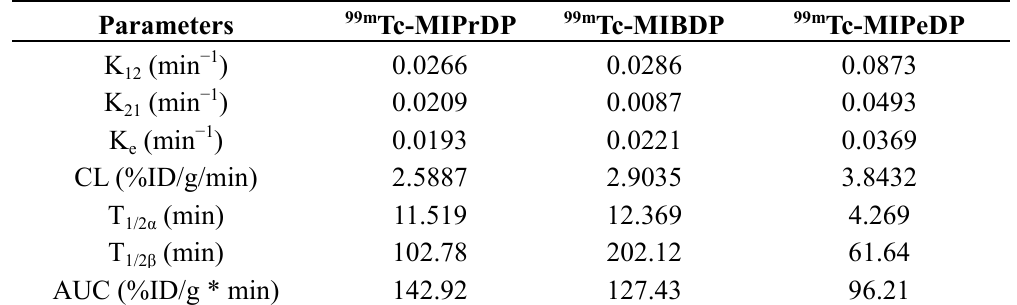
Table 2. Pharmacokinetic parameters of the 5a-5c in mice (mean ± SD, n = 5, %ID/g).